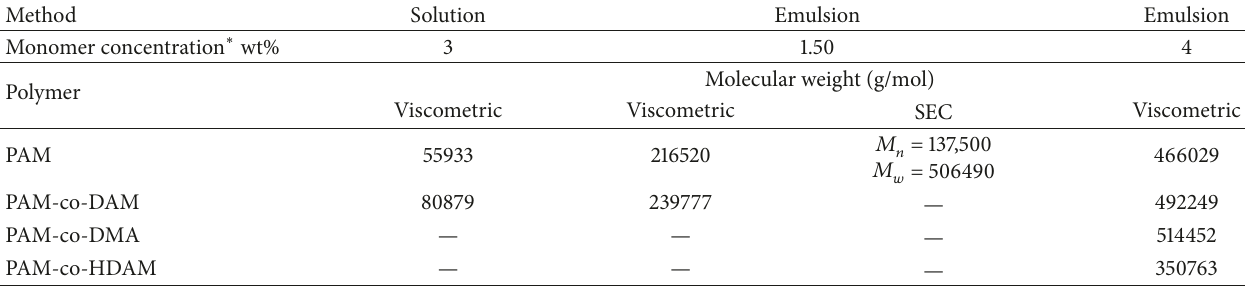
Table 1: Viscometric molecular weight for the different polymers synthetized.